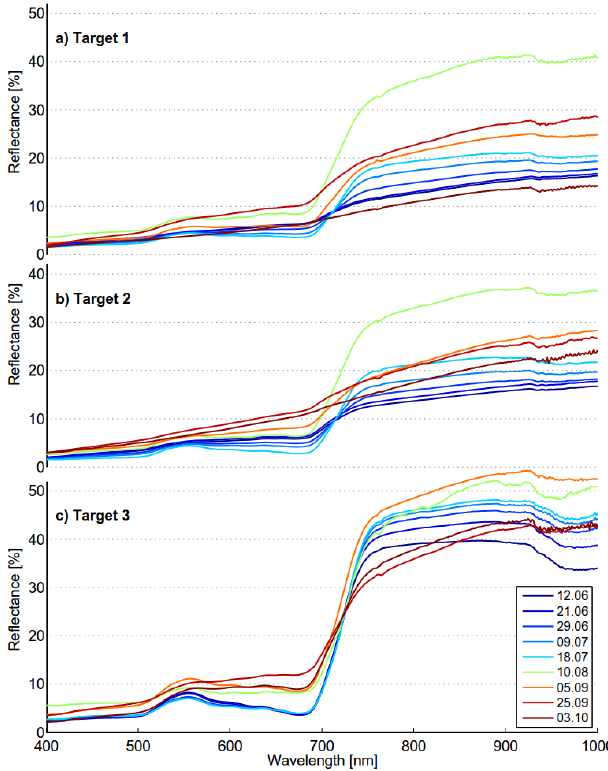
Figure 3. The measured spectra of targets 1, 2 and 3 during the growth period. The measurement dates are shown in the legend. ( a ) Target 1; ( b ) Target 2; ( c ) Target 3.